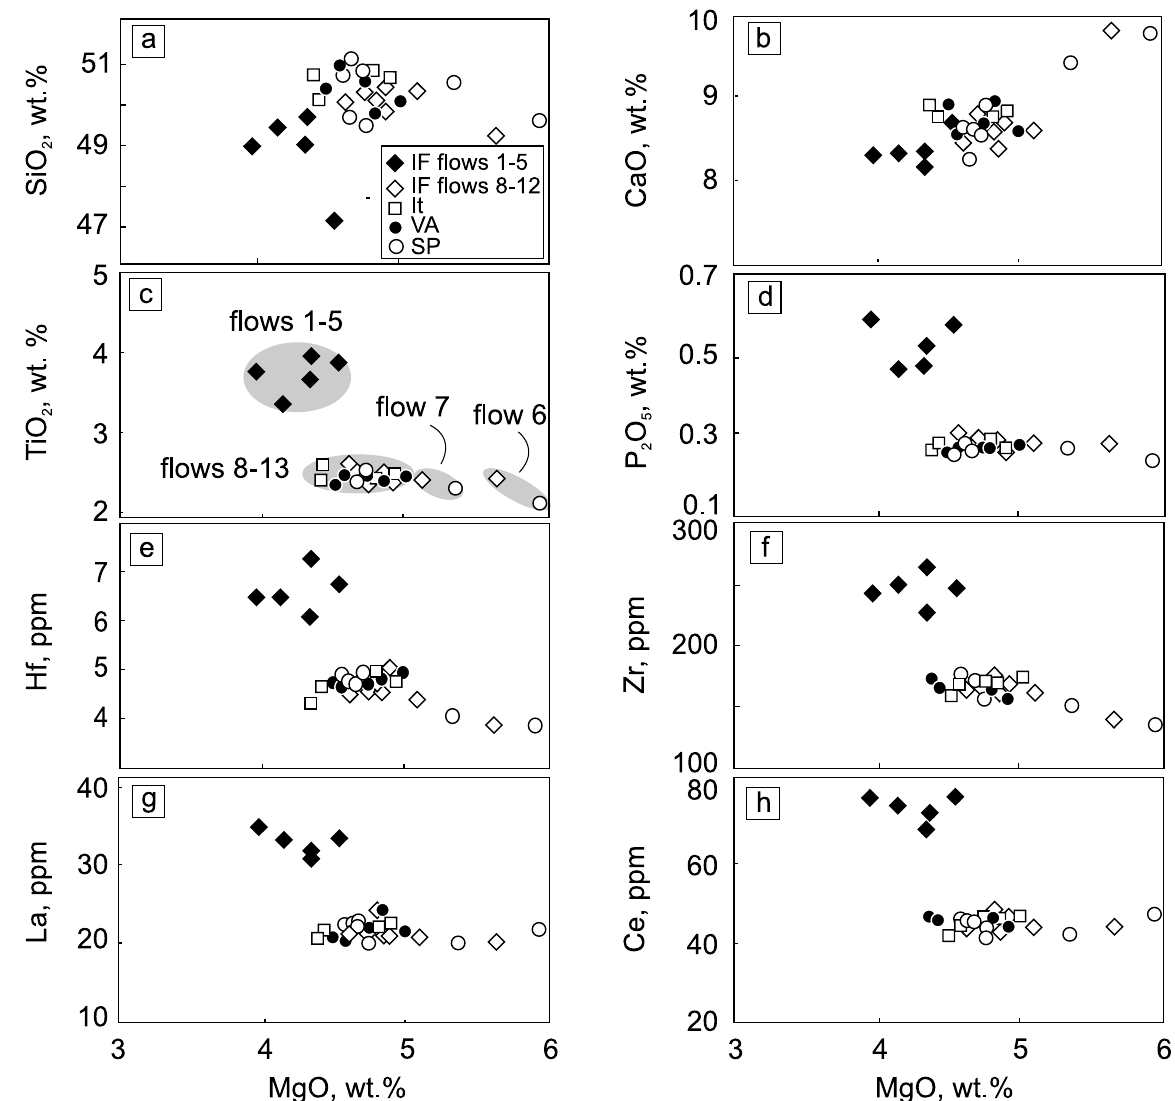
Fig. 7 – Variation diagrams of MgO versus major and trace elements in the flood basalts of the Vista Alegre